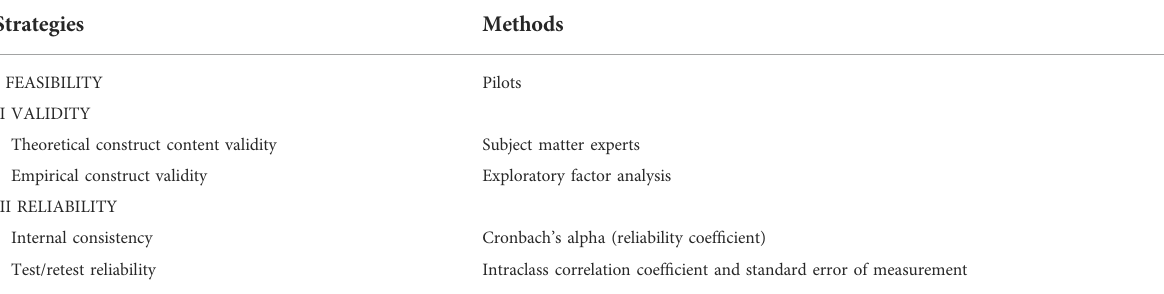
TABLE 1 Validation strategy for the survey